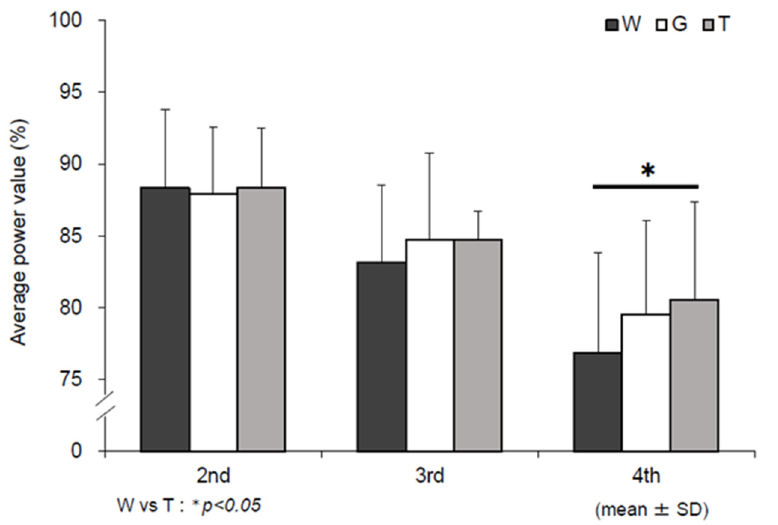
Figure 3. Average power assessments. W—water; G—glucose; T—trehalose. Comparison of mean power values in the Wingate test (2–4 sets) in each trial (water (W), glucose (G), trehalose (T)). The mean of three performances in each set (2nd, 3rd, and 4th) were compared when the first mean power value in the first set of the Wingate test (1st) was set at 100 in each trial. ( n = 12); W vs. T: * p < 0.05.